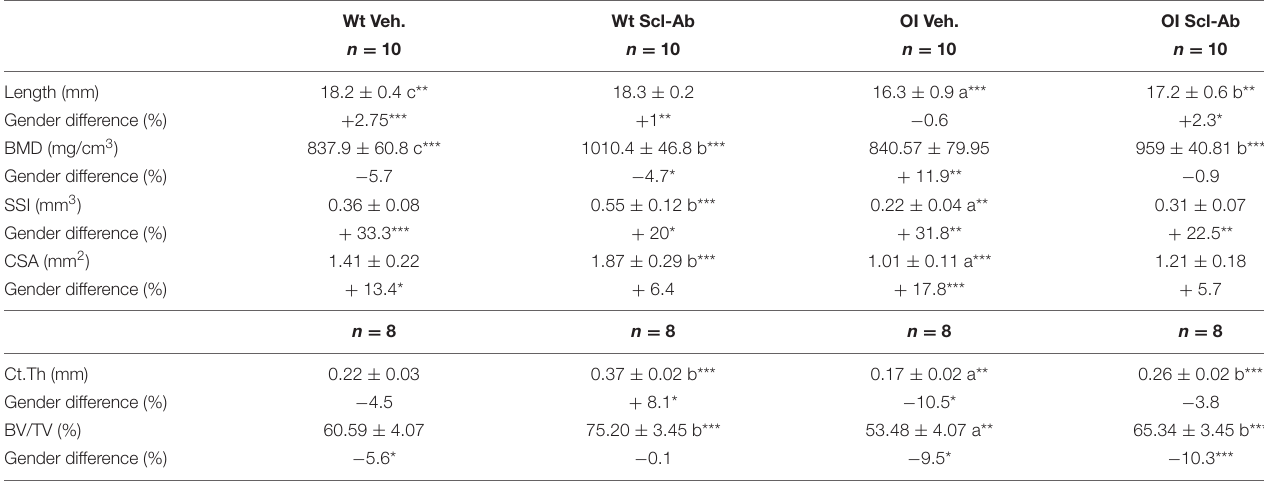
TABLE 4 | Length, midshaft cross-sectional area (CSA), bone mineral density (BMD), polar stress–strain Index (SSI), cortical thickness (Ct.Th), and relative bone volume (BV/TV) of the tibia in male wild-type (Wt) and oim/oim (OI) mice after 9-week treatment with either Scl-Ab or vehicle (Veh.). Wt Veh. Wt